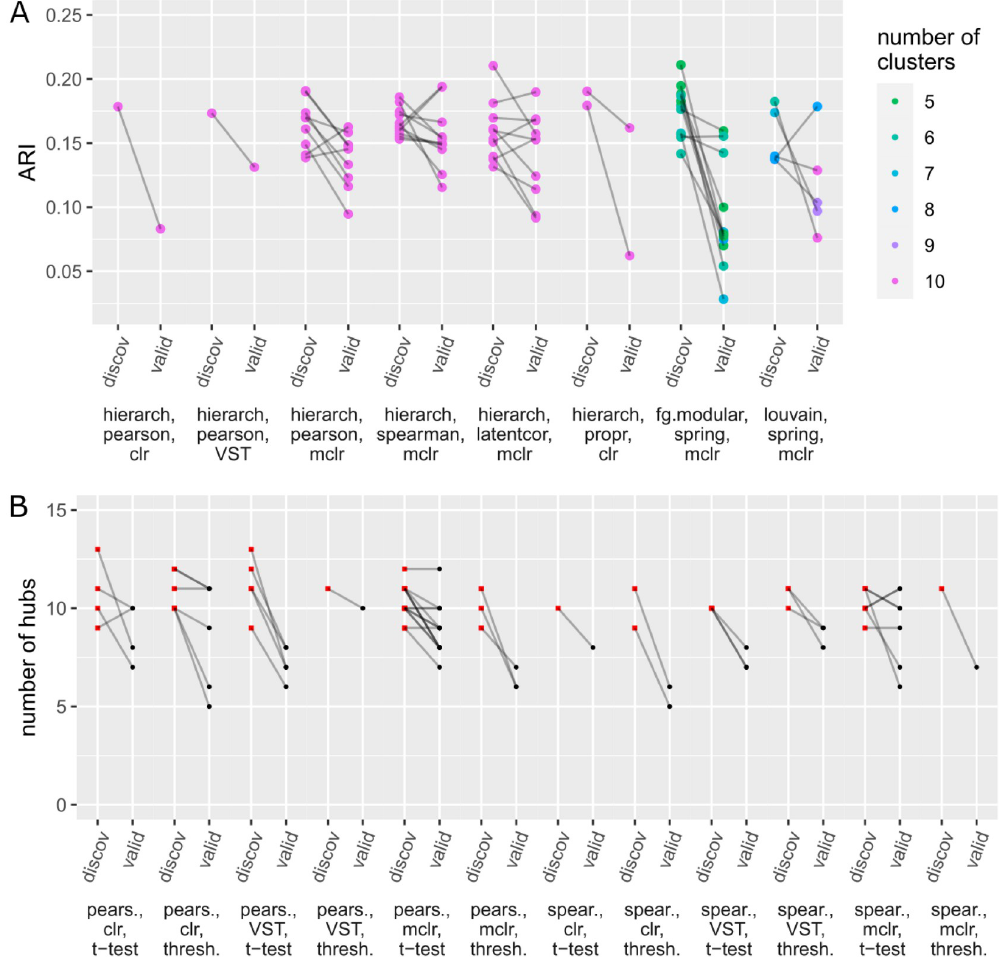
Fig 2. Research tasks 1 & 2: For n = 250, values of the evaluation criteria resulting from the “best” method combinations on the discovery data are compared to the corresponding results on the validation data. On the x -axis, the method combinations that performed best in at least one of the 50 samplings are shown. For each of the 50 samplings, the value of the evaluation criterion on the discovery data (belonging to the best method combination) and the corresponding value on the validation data are connected by a line, resulting in 50 lines overall. As the lines are slightly transparent, overlapping lines appear in a darker shade. a) ARI values for the task of clustering bacterial genera, b) numbers of hubs for the hub detection